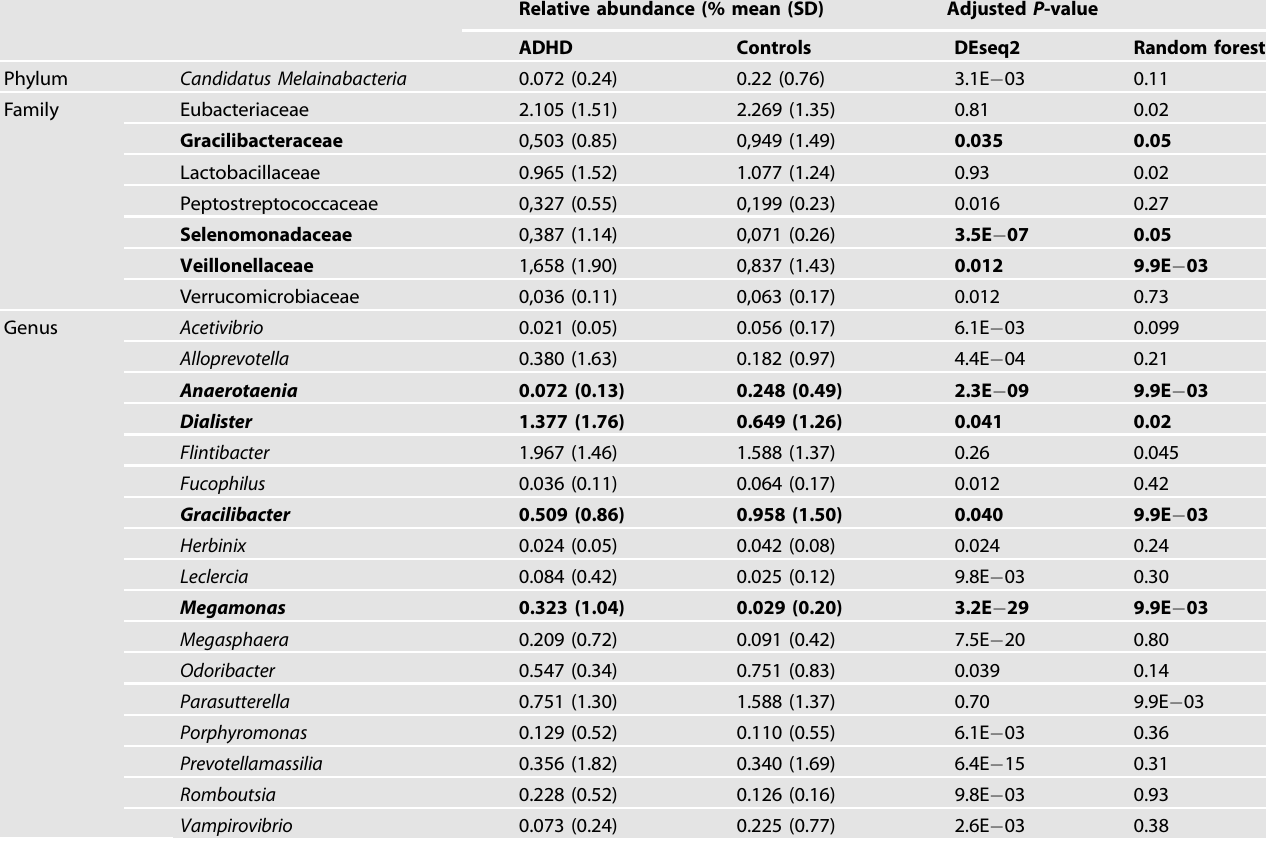
Table 1. Summary of differential abundance results between ADHD patients and controls considering Deseq2 and random forest